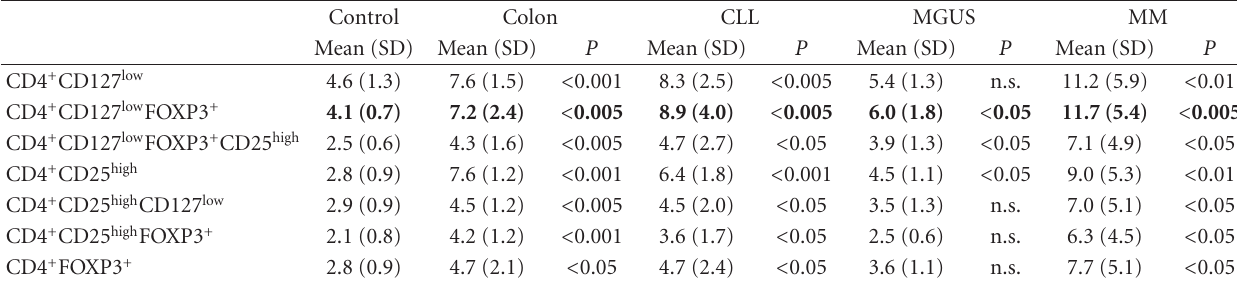
Figure 2: Frequency of CD4 + CD127 low FOXP3 + T reg cells. Flow cytometric analysis of CD127 and FOXP3 expression in CD4 + T cells from (a) peripheral blood of a representative healthy individual (control) and representative patients with colorectal cancer (CRC), CLL, MGUS, and multiple myeloma (MM) and (b) lymph node biopsies from a healthy individual (reactive) and patients with follicular lymphoma (FL) and Hodgkin’s diseases (HD). Table 3: Assessment of T reg -cell frequencies in peripheral